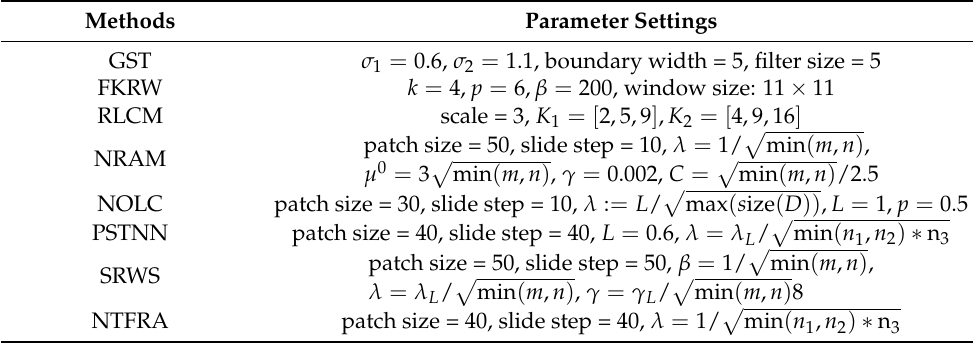
Table 3. Parameter settings for the eight baseline